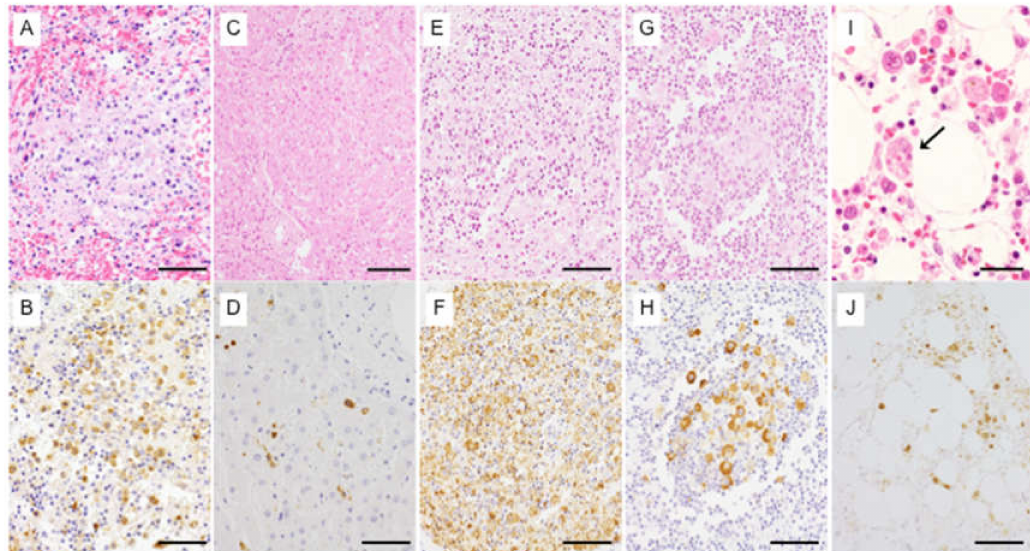
Figure 1. Pathological findings of the patient with SFTS who was possibly infected with SFTSV from a cat also infected with SFTSV. Histopathological and immunohistochemical evaluation of spleen, liver, bone marrow, and lymph nodes. ( A ) Spleen: atypical lymphocyte infiltration and necrotic foci. ( B ) SFTSV antigen detected in the atypical large lymphocytes. ( C ) Liver: centrilobular necrosis and hemorrhage. ( D ) SFTSV antigen detected in Kupffer cells and atypical large lymphoid cells in sinusoids in liver. ( E ) Subclavian lymph nodes: focal necrotizing lymphadenitis. ( F ) SFTSV antigen detected in necrotic debris and large lymphocytes in necrotic foci. ( G ) Sub-carinal lymph nodes: atypical large lymphocytes in follicles. ( H ) SFTSV antigen detected in the follicles of the subcarinal lymph nodes. ( I ) Bone marrow: prominent hemophagocytosis (arrow). ( J ) SFTSV antigen detected in atypical large lymphocytes. Routine hematoxylin and eosin stain: ( A , C , E , G , I ), immunohistochemical staining with anti-SFTSV NP-specific antibody: ( B , D , F , H , J ). Scale bar measurements: ( A , B , D – H , J ), 60 µ m; ( C ), 100 µ m; ( I ), 20 µ m.